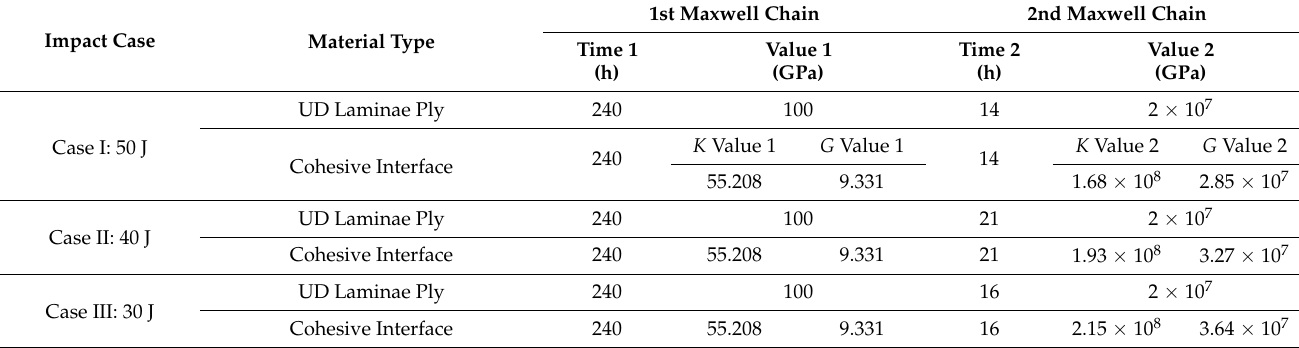
Table 9. Viscoelastic material properties for each impact case.